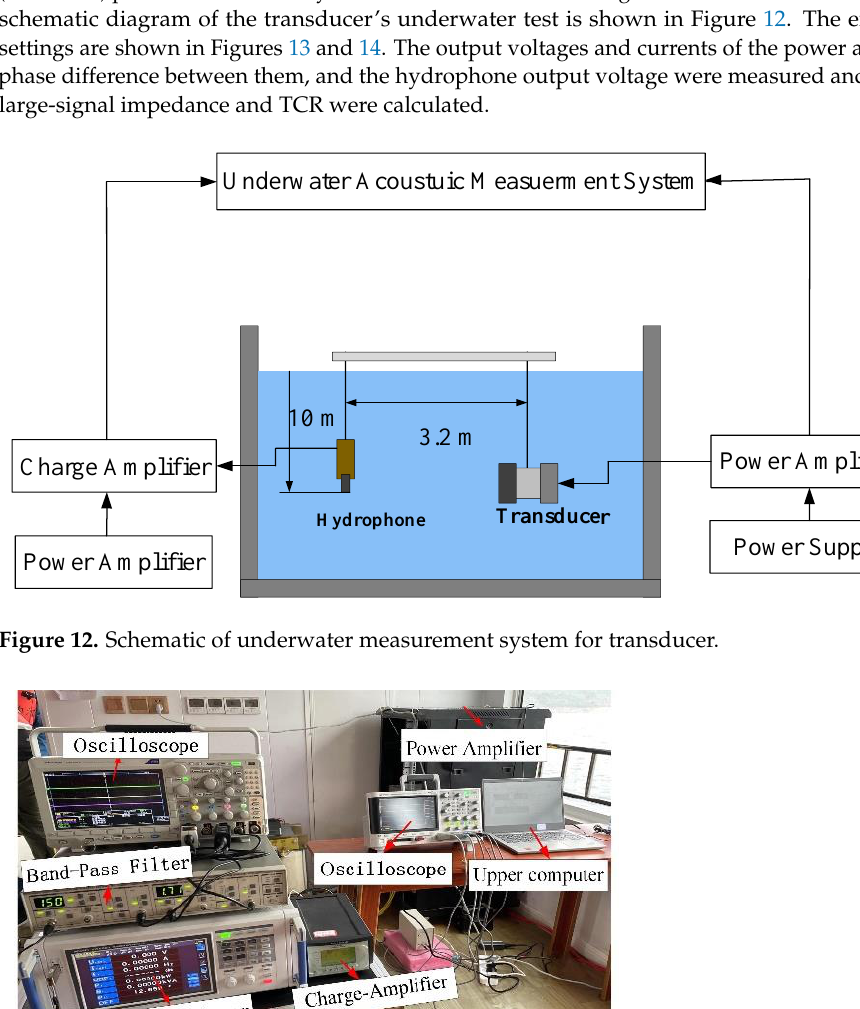
Figure 11. Impedance spectrum in air: ( a ) impedance spectrum of the simulation and experiment without considering eddy loss; ( b ) impedance spectrum of the simulation and experiment considering eddy loss.